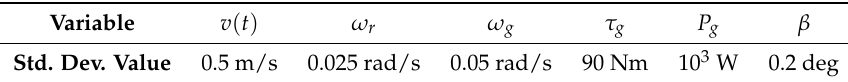
Table 2. Sensor standard deviation values used in the wind turbine simulator